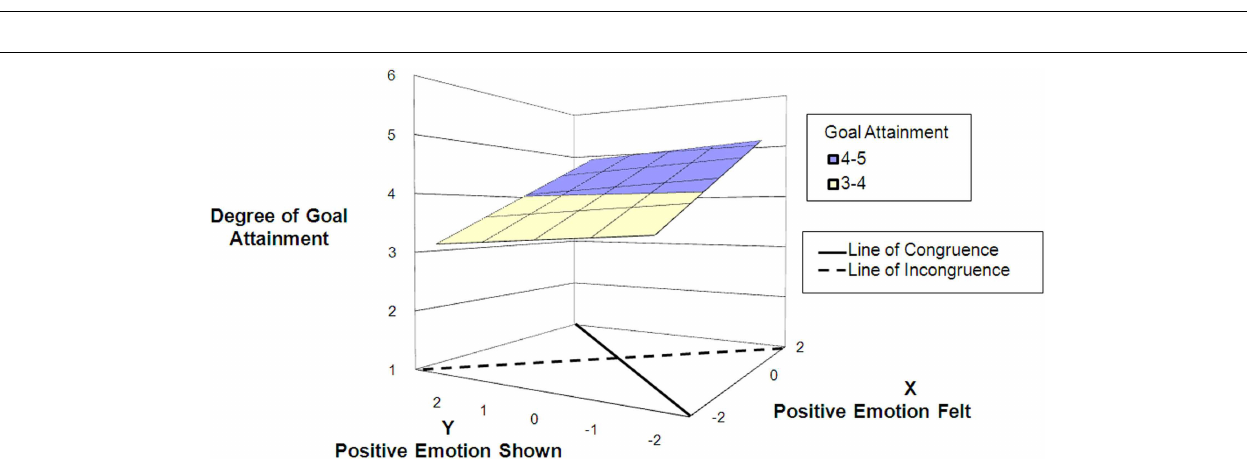
FIGURE 3 | Predicting goal attainment by positive emotions felt and shown during interactions with superiors .